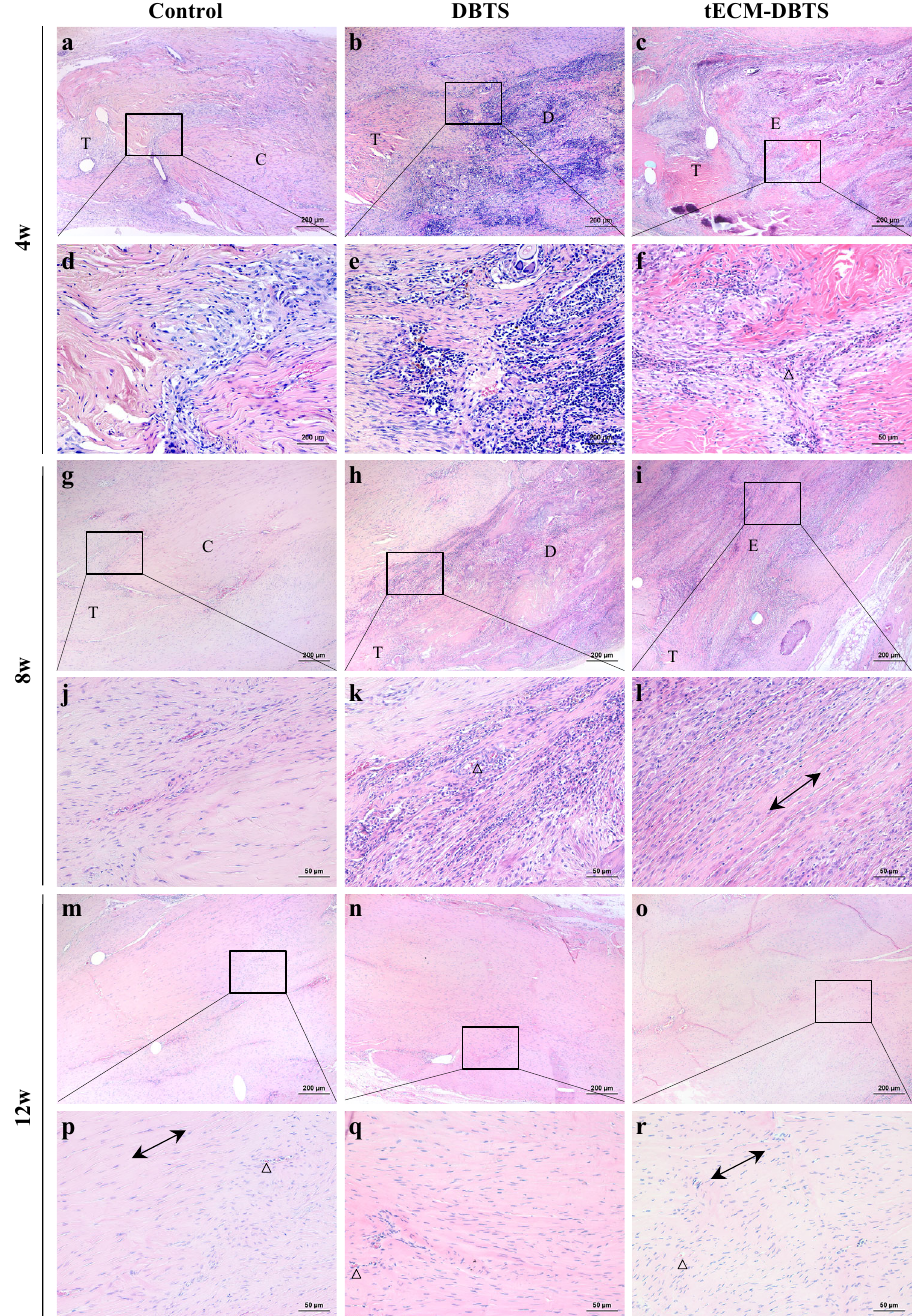
Fig. 6 Representative HE staining of tendon regeneration in a rat Achilles tendons defect model of the control, DBTS and tECM-DBTS group. a – f Postoperative 4 weeks, ( g – l ) 8 weeks and ( m – r ) 12 weeks. The black box is a magni fi cation of the image. Δ represents capillaries. The bidirectional arrows indicate the direction of collagen fi ber alignment. T: Achilles tendon of rat; C: autogenous tendon repair; D: DBTS; E: tECM-DBTS. Scale bar, ( a , b , c , g , h , i , m , n , o ) 200 μ m; ( d , e , f , j , k , l , p , q , r ): 50 μ